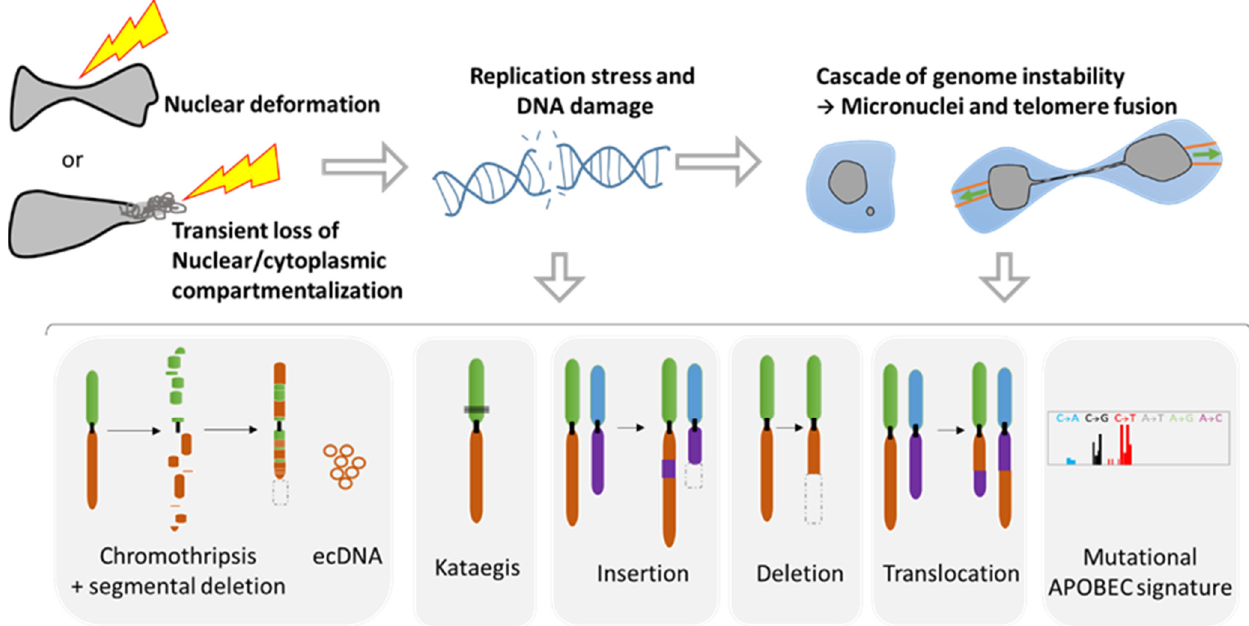
Figure 3. Genomic instability associated with nuclear squeezing and nuclear envelope rupture leads to the generation of genomic diversity. Nuclear deformation and nuclear envelope collapse, displaying a transient loss of compartmentalization, lead to replication stress and DNA damage. This DNA damage can initiate a cascade of genomic alterations in the next mitosis with the generation of micronuclei and telomere fusion, provoking a chromatin bridge. Such events are known to initiate a myriad of diverse genomic events such as chromothripsis, extra chromosomal DNA (ecDNA), the hypermutated pattern Kataegis, events of insertions, deletion, and translocation, as well as the mutational signature APOBEC (Adapted from Gauthier BR, et al. [27]).